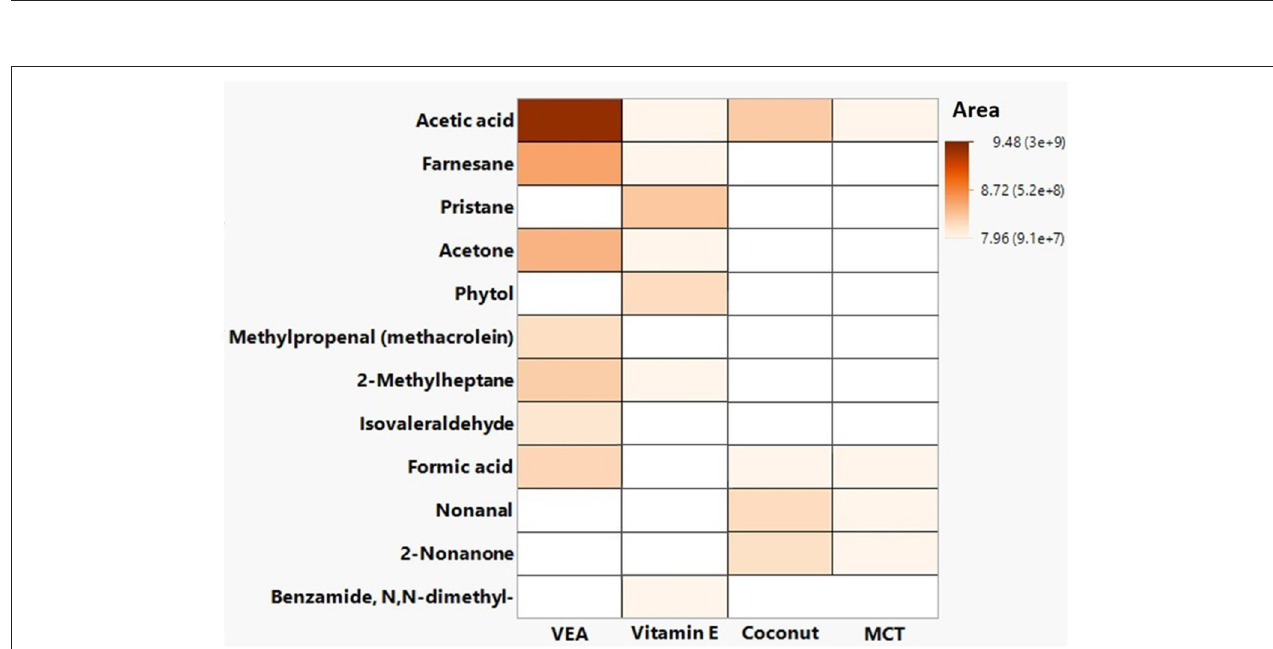
FIGURE 4 | Confirmed hazardous chemical emissions from vitamin E acetate (VEA), vitamin E oil, coconut oil, and medium chain triglycerides (MCT) during general volatile organic compound sampling.